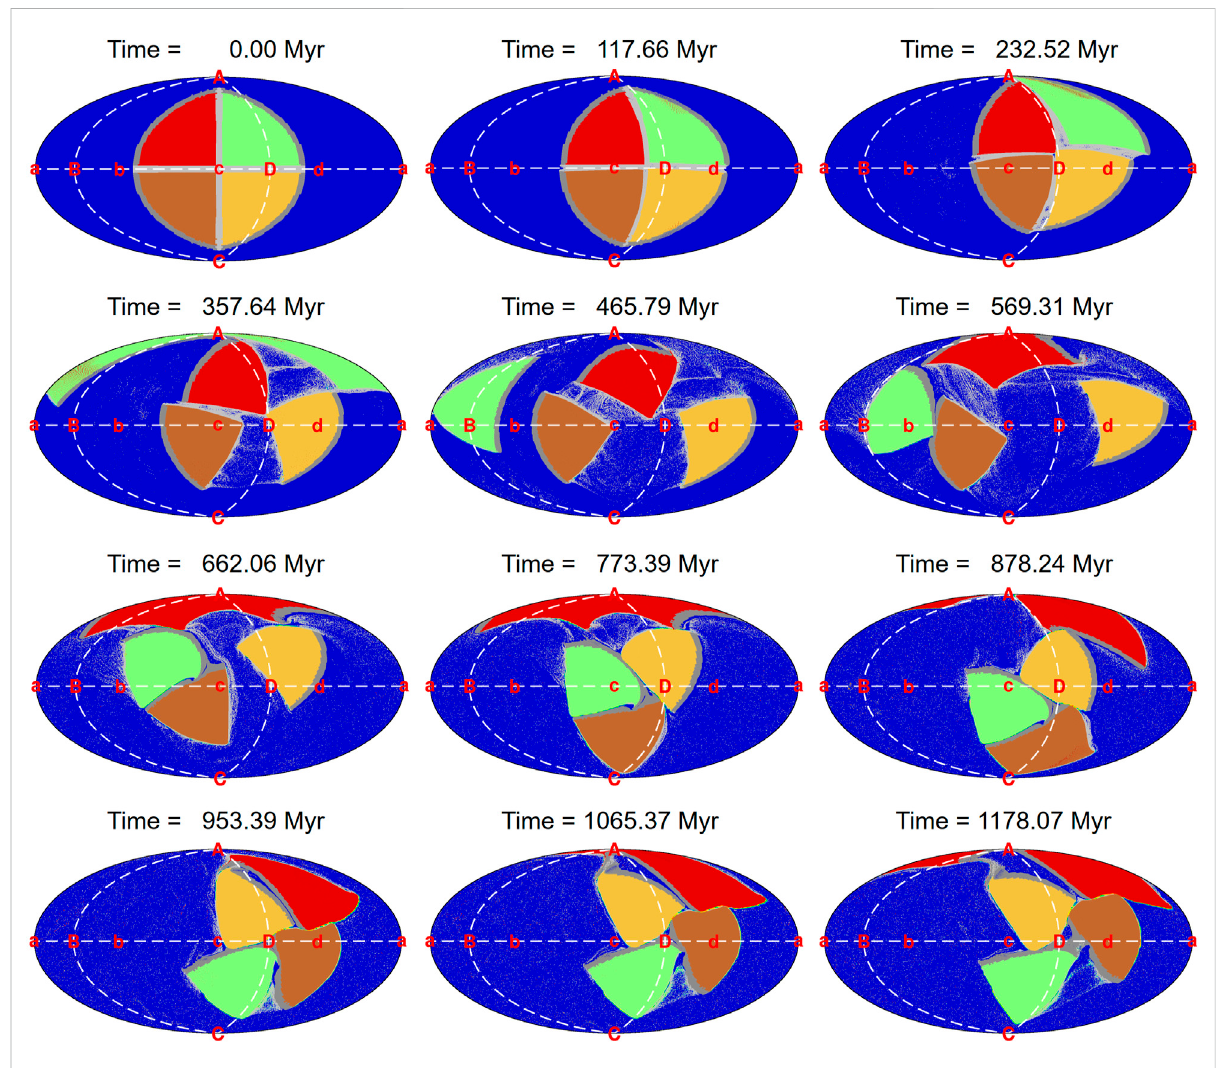
FIGURE 7 Timesequenceofthedriftingcontinentsfromtheinitialsupercontinent,dispersalofthecontinentalpieces,toamalgamationandreassemblyof the next supercontinent over ~1,200 million years after Model Y200_20a0 by Yoshida (2013). The color coding indicates the ocean area (blue), and thefourcontinentpieces(red, palegreen,brown, yellow). Thealphabet labels indicateasetofgeographically fi xedpointsalongthelongitudinal and equatorial sections for describing the global positions of continent pieces and the convective geometry in the main text; “ A ” to “ D ” for the longitudinal section ( “ A ”–“ B ”–“ C ”–“ D ”–“ A ” ) and “ a ” to “ d ” for the equatorial section ( “ a ”–“ b ”–“ c ”–“ d ”–“ a ”